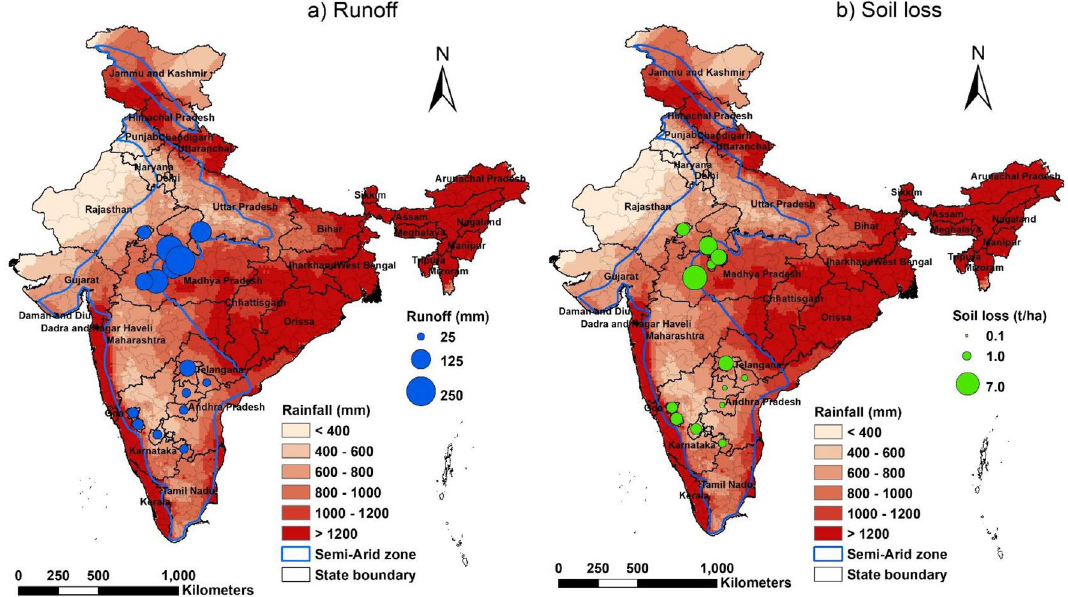
Figure 9. Spatial variability in ( a ) runoff and ( b ) soil loss in response to rainfall in different study watersheds.